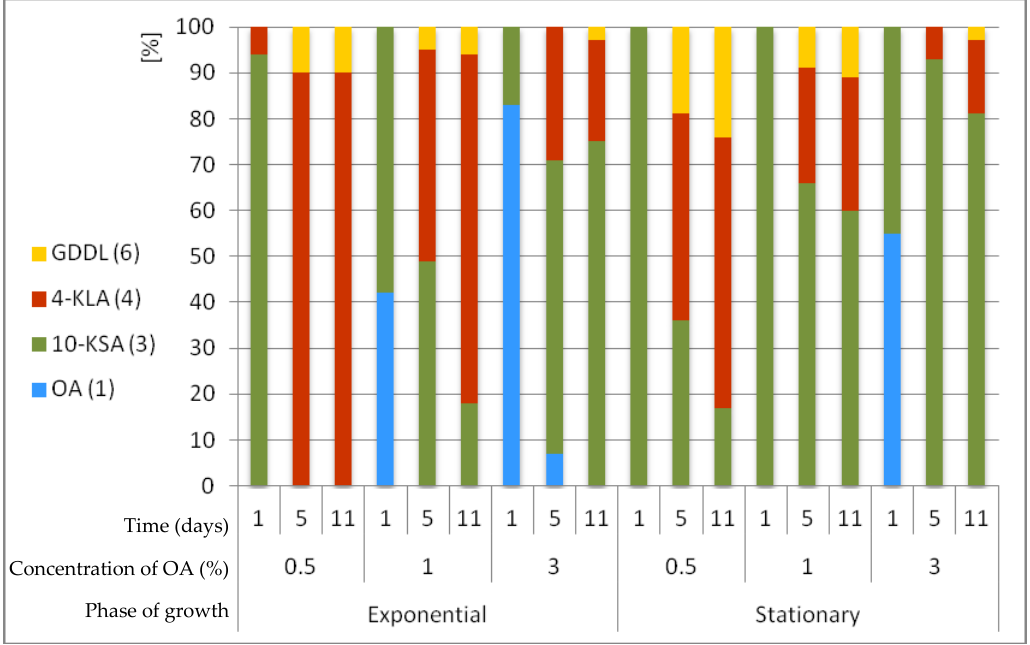
Figure 1. Effect of Micrococcus luteus PCM525 growth phase and concentration of substrate on transformation of oleic acid ( 1 ) (in % according to GC–MS).